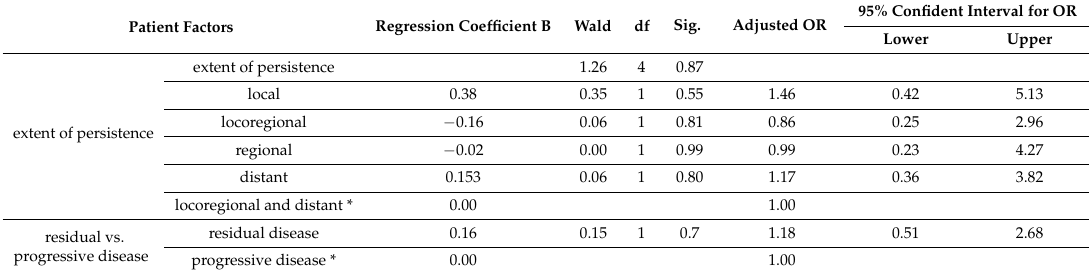
Table 5. Multivariate logistic regression model: Influential patient factors for overall survival after second-line treatment. (RT: Radiotherapy, RCHT: Radiochemotherapy, CHT: Chemotherapy, ASA Score: American Society of